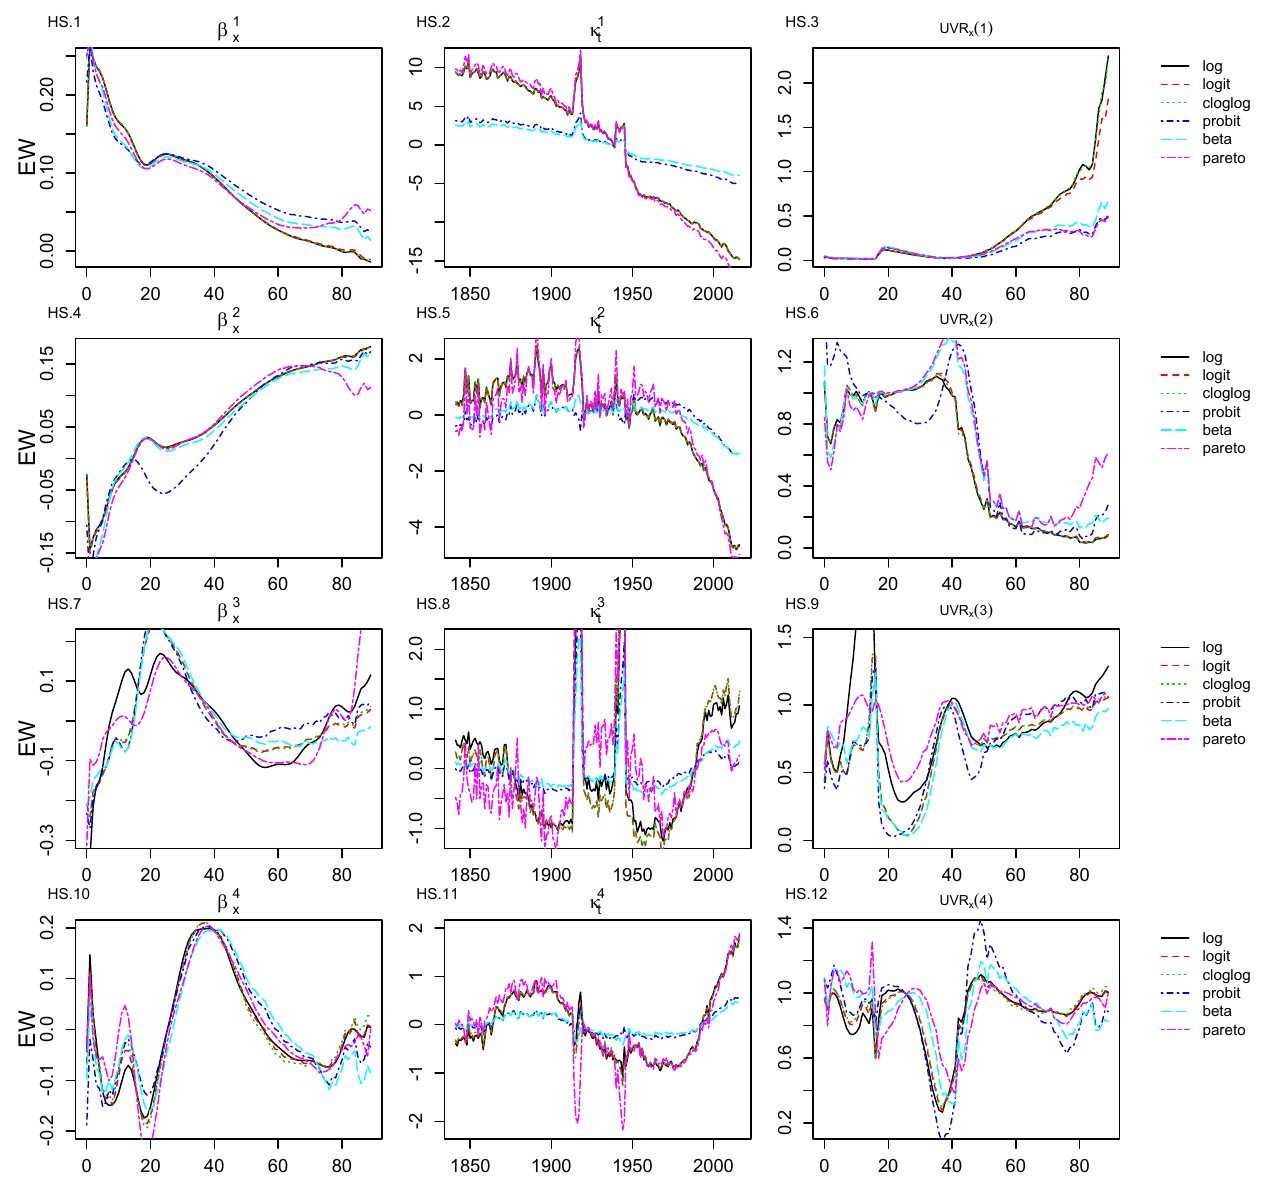
Figure A1. First to fourth age-period component for E&W